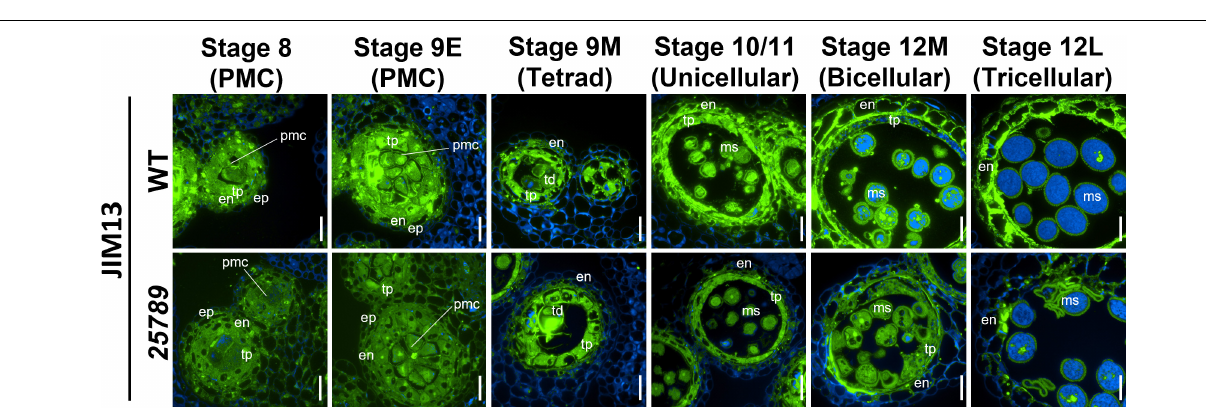
FIGURE 6 | Distribution of JIM13-epitope labeling of AGPs in microsporocytes and microspores of galt25789 mutants and WT. Cross sections of resin-embedded anthers of WT (Col-0) and galt25789 from stages 8 to 12L were labeled with JIM13 primary antibodies followed by Alexa Fluor 488-labeled secondary antibody labeling subsequently. Fluorescence of Alexa Fluor 488 (green) and autofluorescence (blue) was separately captured by epifluorescence microscopy and merged. Scale bar = 20 µ m. en-endothecium; ep-epithelium; ms-microspore; pmc-pollen mother cell; td-tetrad;